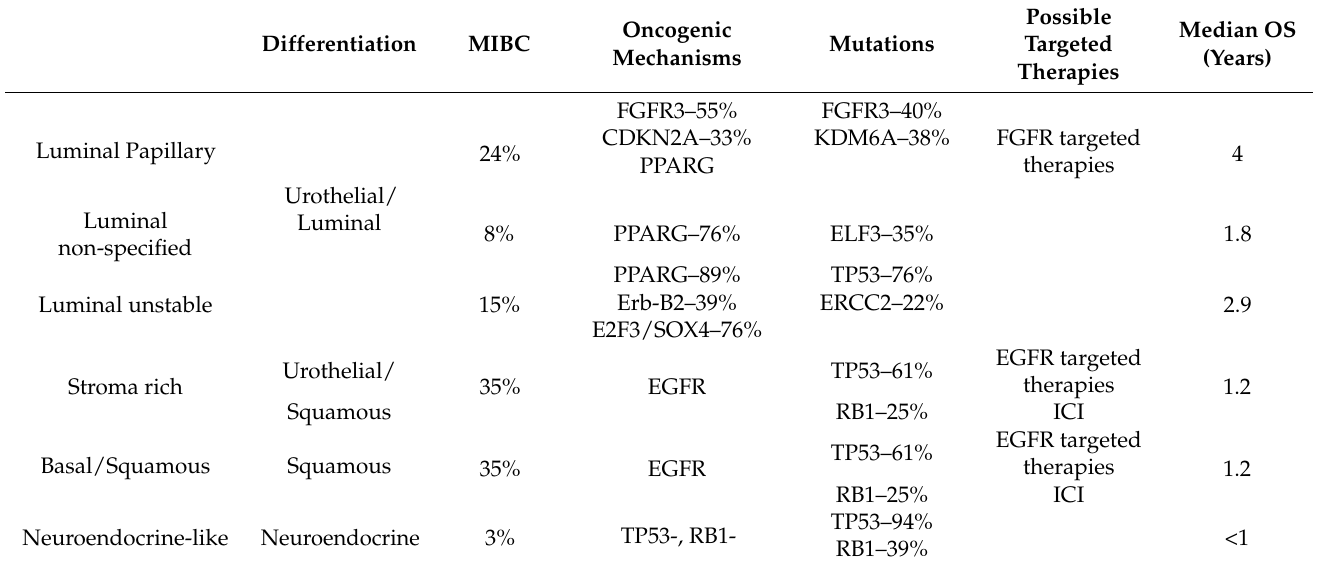
FGFR—fibroblast growth factor receptor. CDKN2A—cyclin-dependent kinase inhibitor 2A. KDM6A—lysine demethylase 6A. PPARG—perixosome proliferator activated receptor gamma. ELF3—ETS-related transcription factor. EGFR—Epidermal growth factor receptor. ICI—immune-checkpoint inhibitor. Adapted from Kamoun et al. Eur Urol.